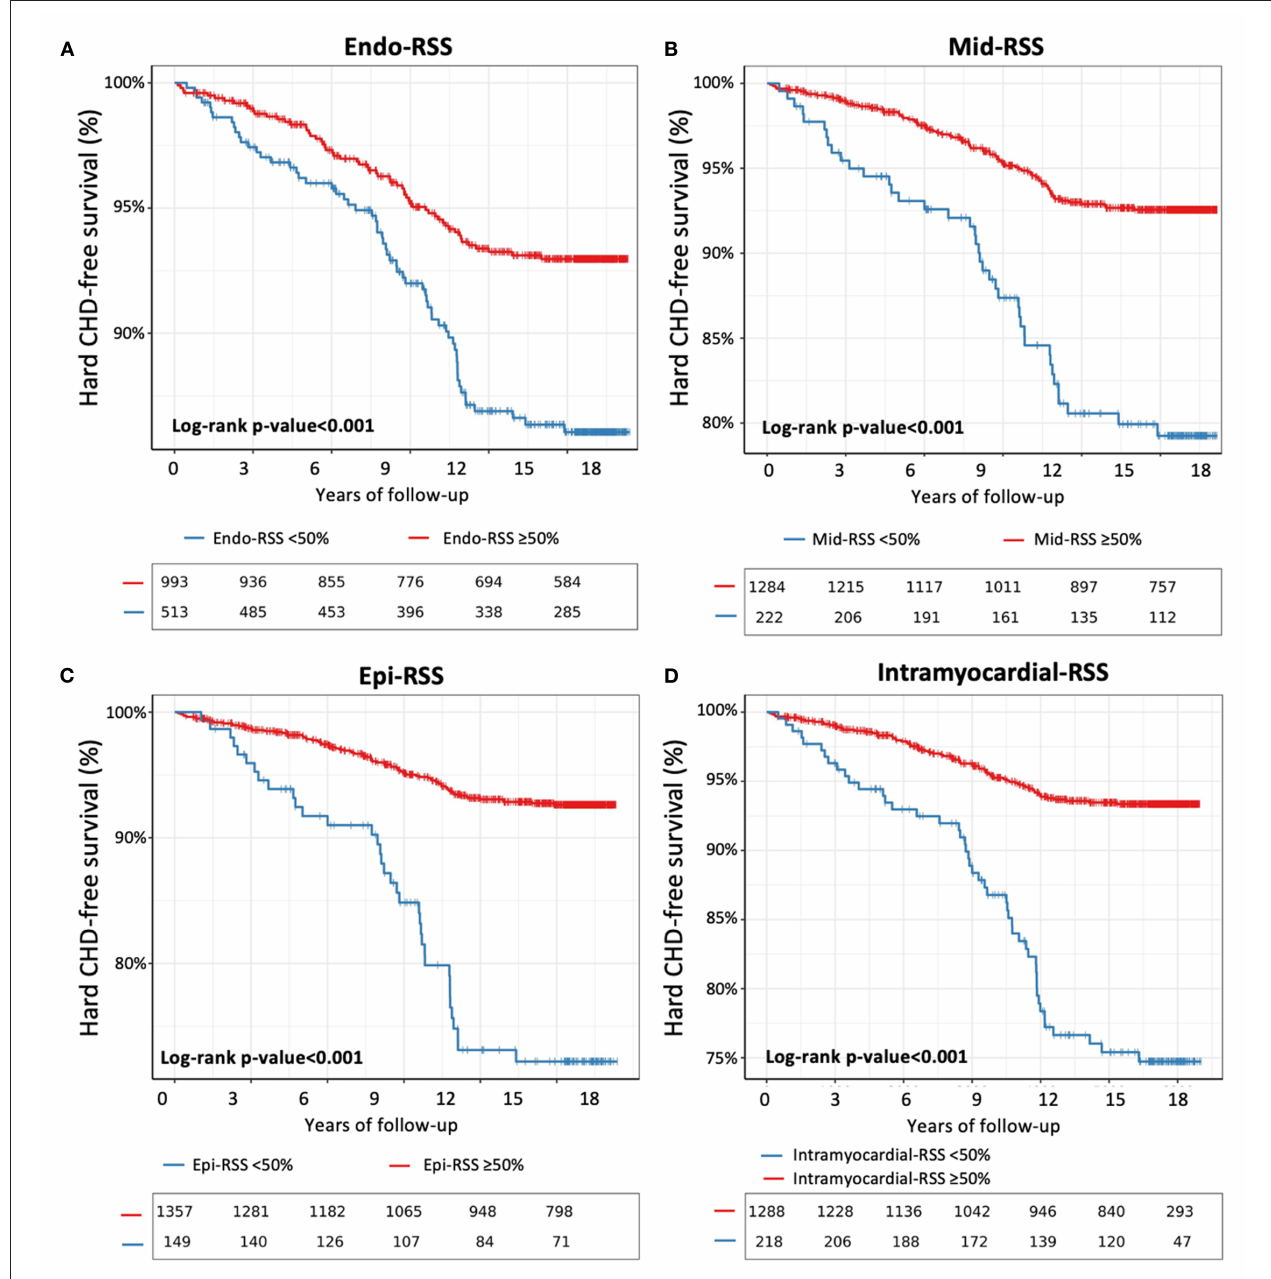
FIGURE 4 | Kaplan–Meier survival curves for incident hard CHD stratified by Endo-RSS < 50% (A) , Mid-RSS < 50% (B) , Epi-RSS < 50% (C) , and intramyocardial-RSS < 50% (D)